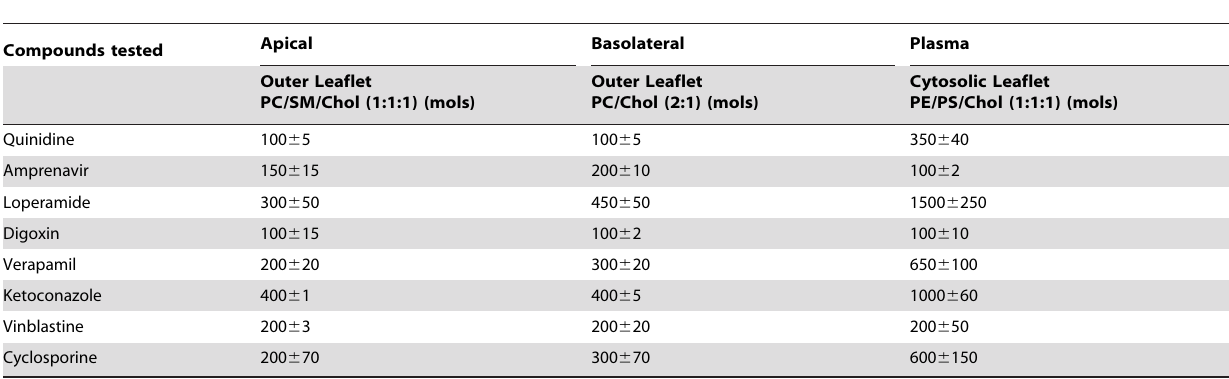
Table 1. Molar Partition Coefficients to 0.1 m m Extruded Unilamellar Liposomes.